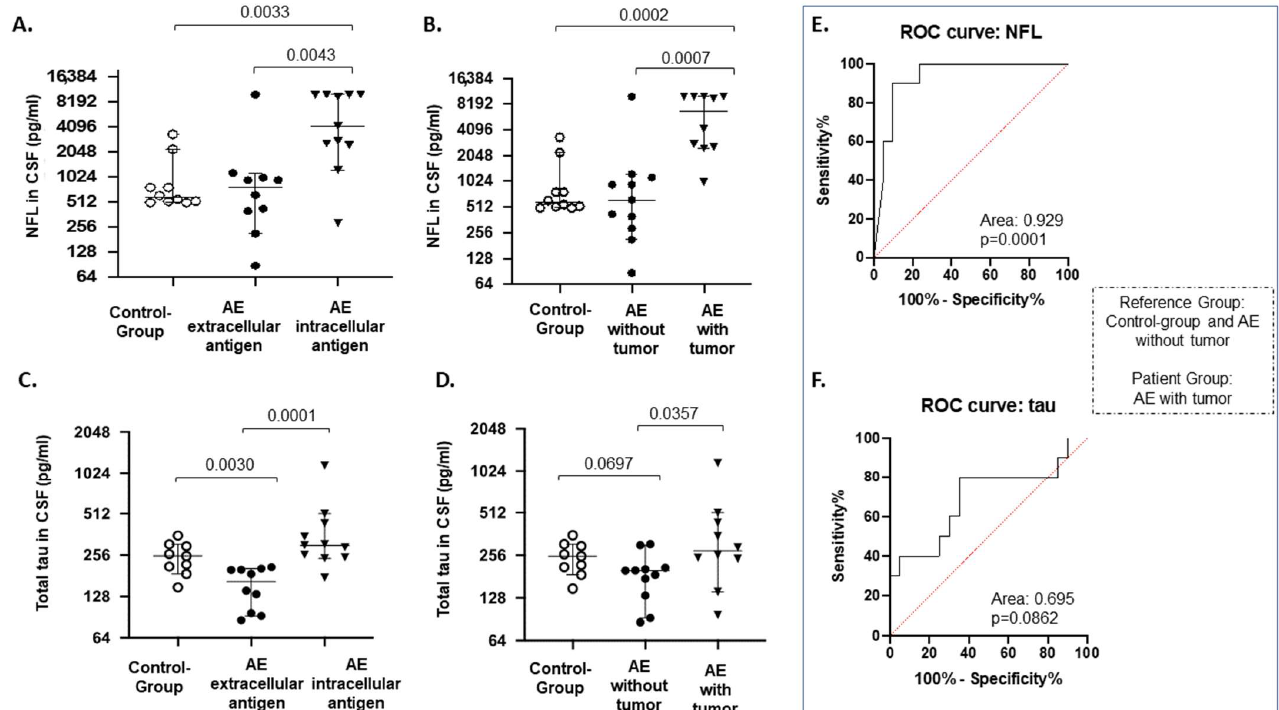
Figure 1. Biomarkers of neuronal and neuroaxonal injury at disease exacerbation. ( A , B ) Cerebrospinal fluid (CSF) NFL levels and ( C , D ) total tau levels were compared between the control group ( n = 10) and patients with autoimmune encephalitis (AE). In panels A and C, each group of patients was subdivided into those associated with the presence of autoantibodies against extracellular antigens and those associated with the presence of autoantibodies against intracellular antigens. In panels B and D, each group of patients was subdivided into the those associated with the presence of an underlying tumor and those not associated with the presence of tumor. ( E , F ) Receiver operating characteristic curve (ROC) analysis displaying the trade-off between sensitivity (true-positive rate) and (100% specificity) (false-positive rate). ROC curves tested the ability of each biomarker to discriminate the reference group (the control group and patients with AE without tumors) from the group of interest (patients with AE and tumors). For NFL: area under the curve = 0.9286, standard error = 0.04694 and 95% confidence interval: 0.8366 to 1.000; p -value = 0.0001. This analysis indicated that the best cut-off for CSF-NFL was >969 pg/mL, with the corresponding sensitivity and specificity to predict the presence of tumor set at 100% and 76.19%, respectively ( E ). ROC curve statistics for total tau were not statistically significant: area under the curve = 0.6950, p = 0.0862 ( F ). The horizontal lines in the dots represent the median. The vertical lines indicate the 95% CI, confidence interval. The p -values were obtained via unpaired t -test analysis using the Mann–Whitney test. p -values are indicated in the figure, and statistically significant comparisons were considered as those with p < 0.05. CSF = cerebrospinal fluid; AE = autoimmune encephalitis; NFL = neurofilament light